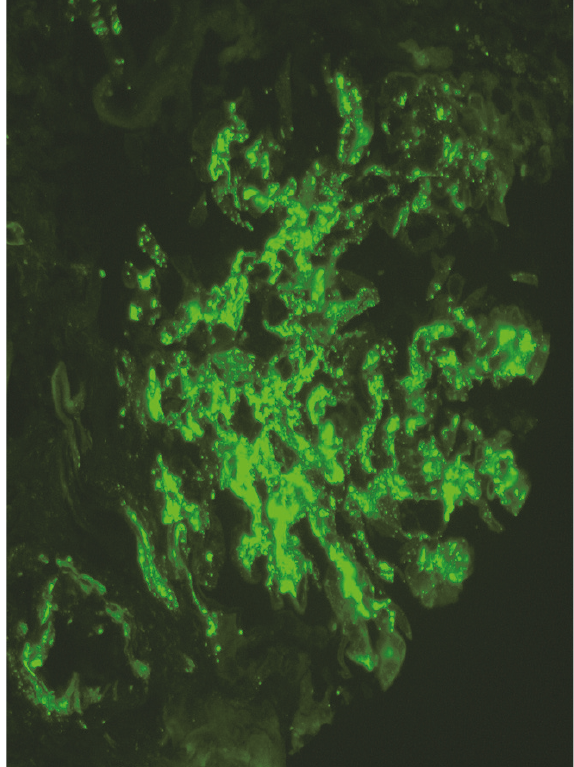
Figure 3: Global 3+ mesangial deposit of immunoglobulin A is present (immunofluorescent, x